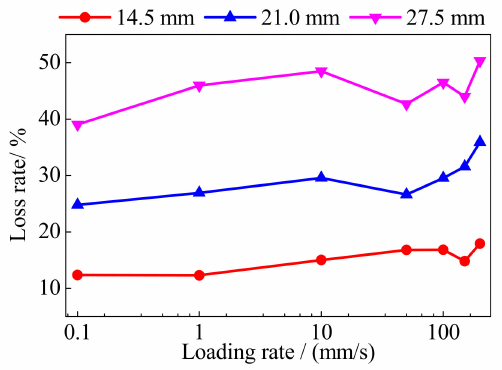
Figure 11. Loss rate of the prestressed force.